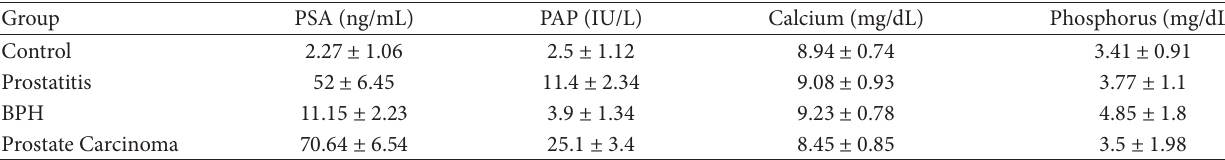
Table 2: The table shows the mean levels of various biomarkers in different groups.